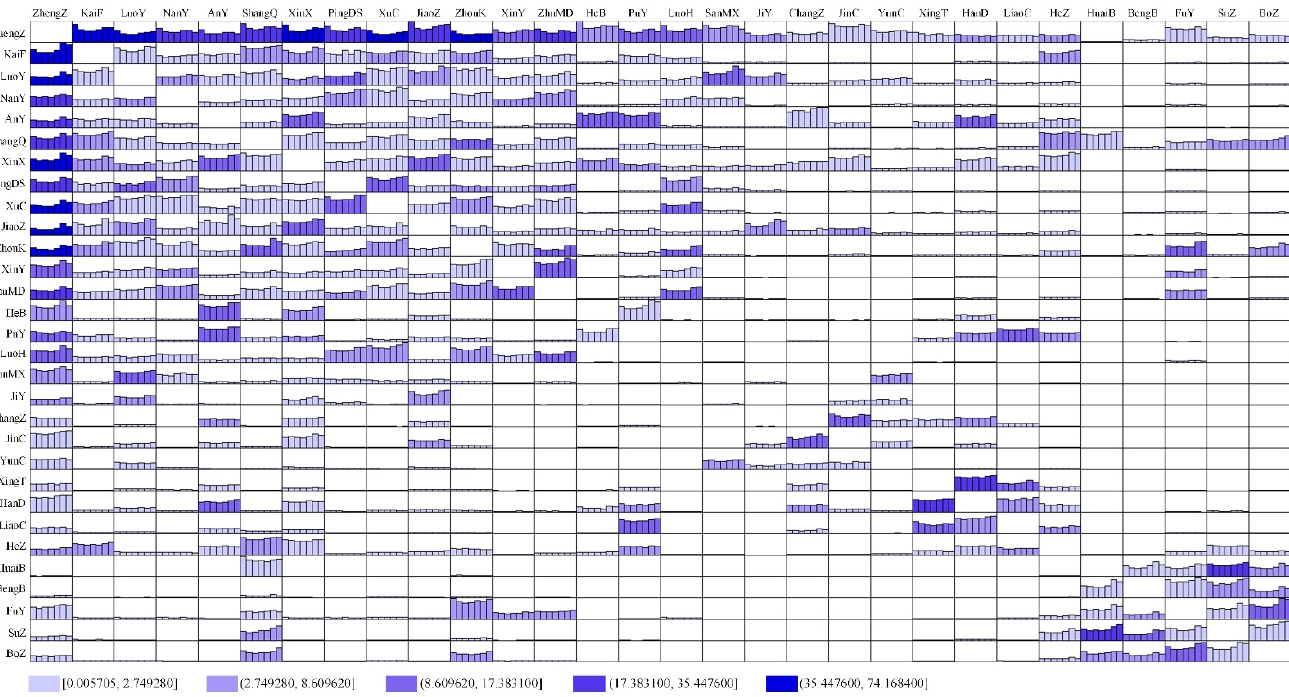
Figure 11. Migration variation visualization based on graded TimeCell.